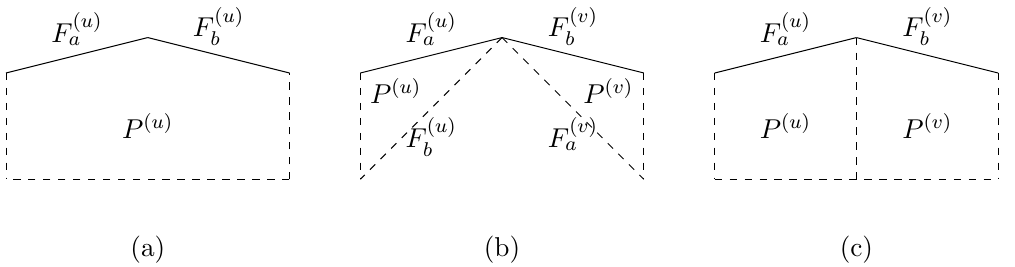
Figure 15 . A cross section image of the three possible ways which neighbouring faces in a loop C on M could be connected. In (a) the neighbouring faces are associated with a single polyhedral cell. In (b) neighbouring faces are associated with polyhedral cells which share a single common edge. In (c) the neighbouring faces are associated with polyhedral cells which share a common edge. The (cid:12)gures all represent cross-sections of the tessellations, and in all (cid:12)gures dashed edges represent faces of polyhedra which do not form part of M , while solid edges represent faces of polyhedra which form part of M